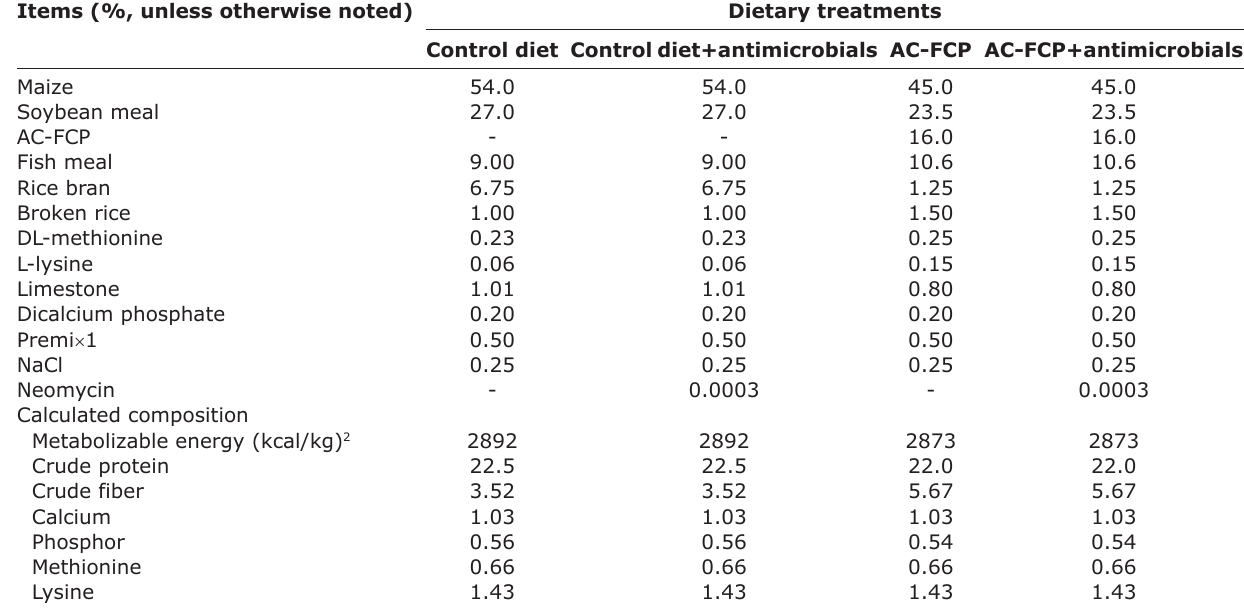
Table-1: Ingredients and composition (as-dry basis) of treatment diets. Items (%, unless otherwise noted) Dietary